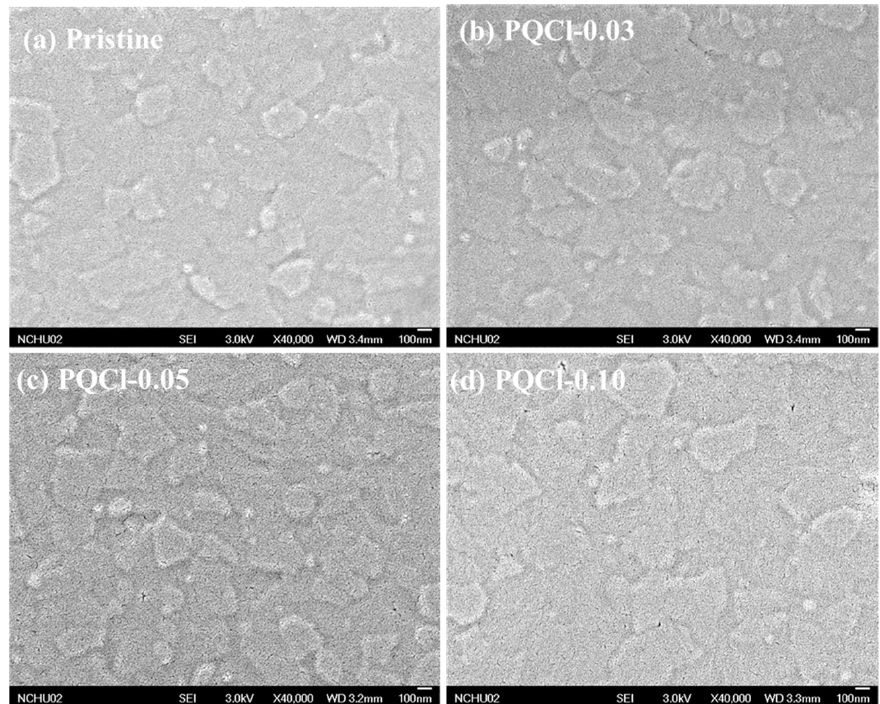
Figure 2. SEM images of the PQCl-deposited NiO x layers: ( a ) pristine, ( b ) PQCl-0.03, ( c ) PQCl-0.05, and ( d ) PQCl-0.10.